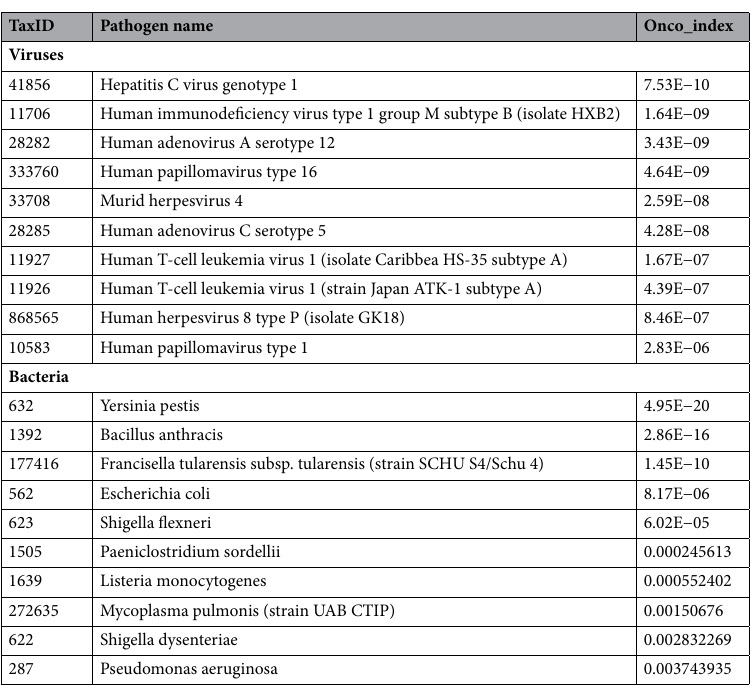
Table 5. Top 10 most oncogenic/oncolytic viruses and bacteria ranked by their